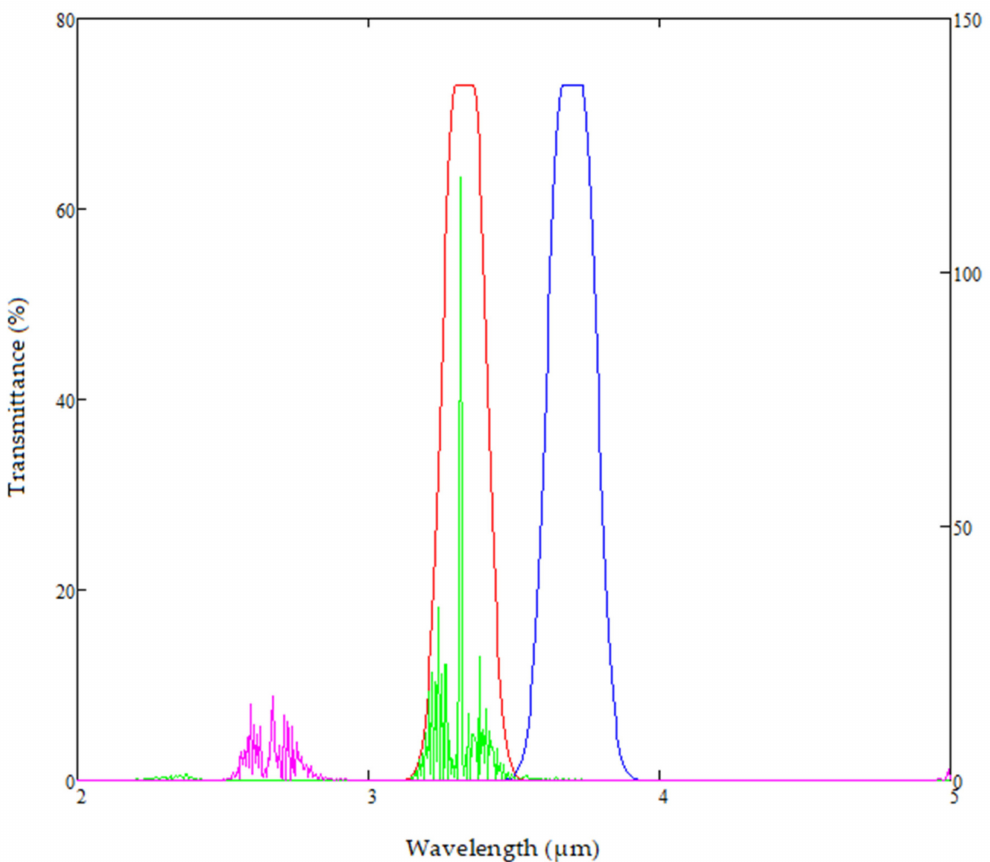
Figure 10. Signal and Reference filter placement using fixed pass band optical filters.